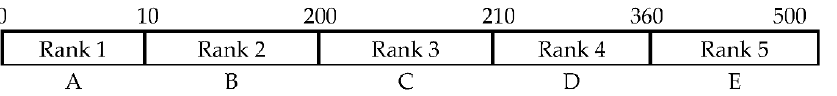
Figure 1. Comparison of the arithmetic mean calculation for metric and expressed as ordinal quantities: above—the possible limits of the metric values on the ratio scale, below—scores assessed by experts, in this case, these are also ranks 1, 2, 3, 4, 5. For scores (ordinal quantities), we have the arithmetic mean Х mean(ordinal) = (1 + 2 + 3 + 4+5)/5 = 3, not depending on which values the metric quantity takes in a particular range.